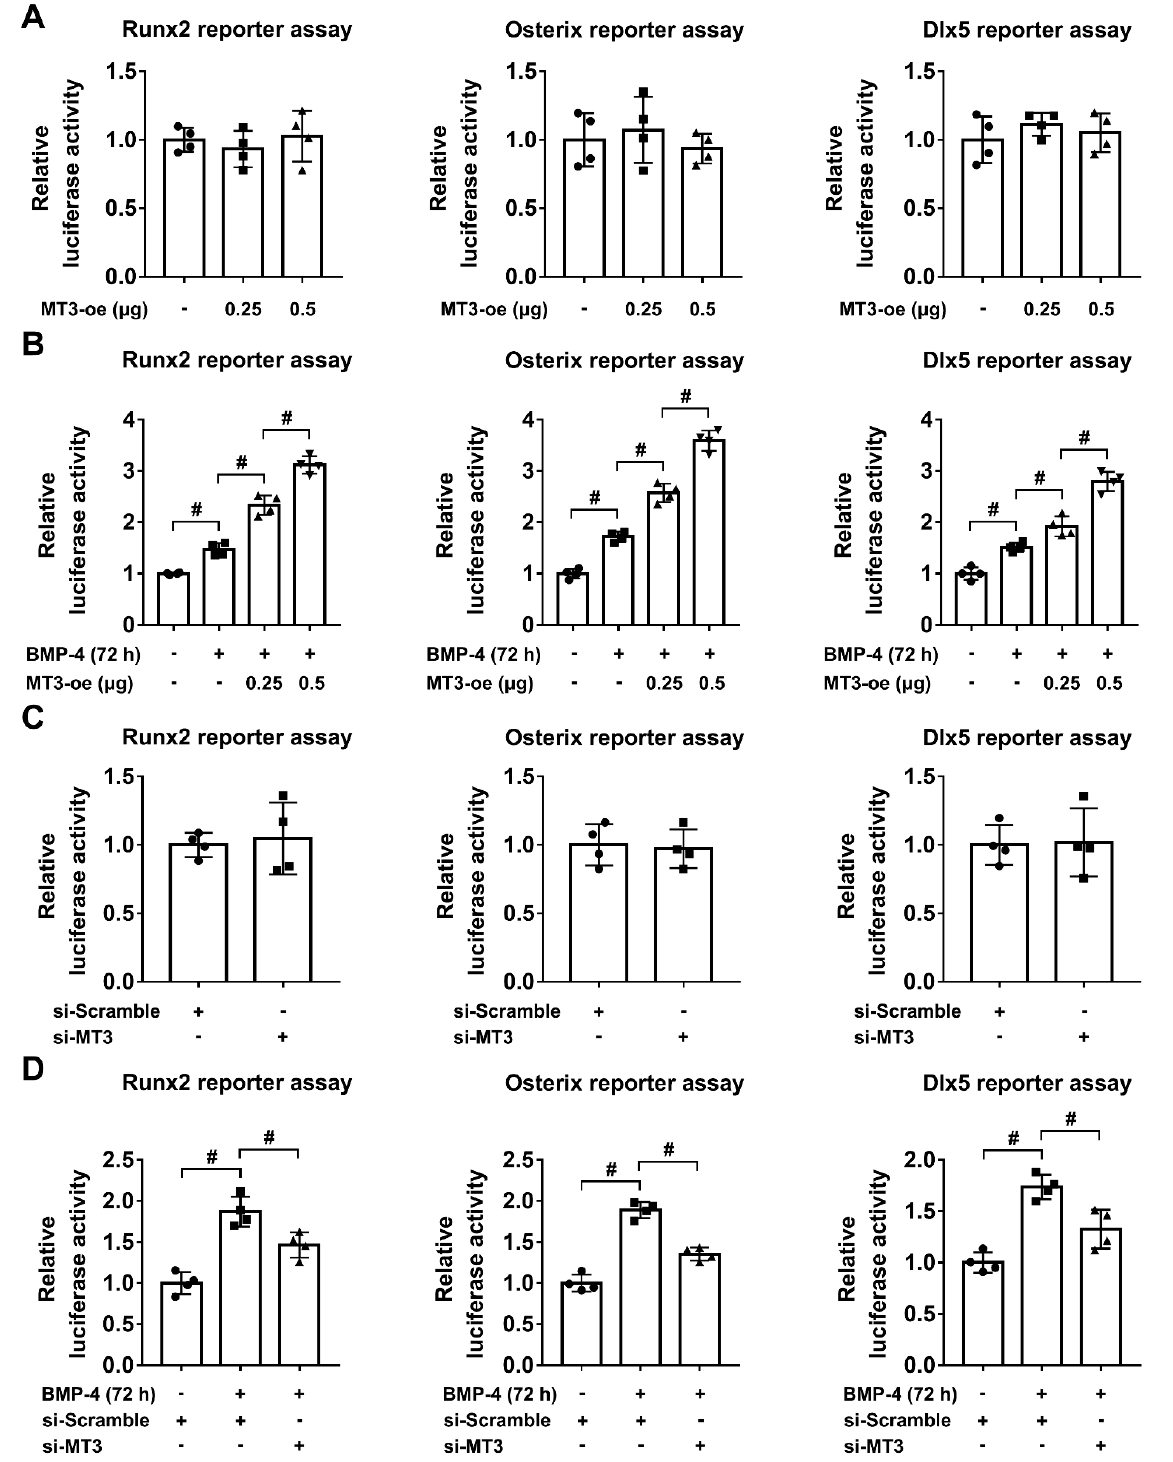
Figure 4. MT3 indirectly regulates Runx2/Osterix/Dlx5 activation during osteoblast differentiation. ( A ) Luciferase reporter activities of Runx2, Osterix, and Dlx5 in control or MT3-overexpressing 293T cells. ( B ) Luciferase reporter activities of Runx2, Osterix, and Dlx5 in control or MT3-overexpressing C2C12 cells treated with or without recombinant BMP4 for 72 h. ( C ) Luciferase reporter activities of Runx2, Osterix, and Dlx5 in control or MT3 knockdown 293T cells. ( D ) Luciferase reporter activities of Runx2, Osterix, and Dlx5 in control or MT3 knockdown C2C12 cells treated with or without recombinant BMP4 for 72 h. All data are presented as mean ± SEM, # p < 0.05.